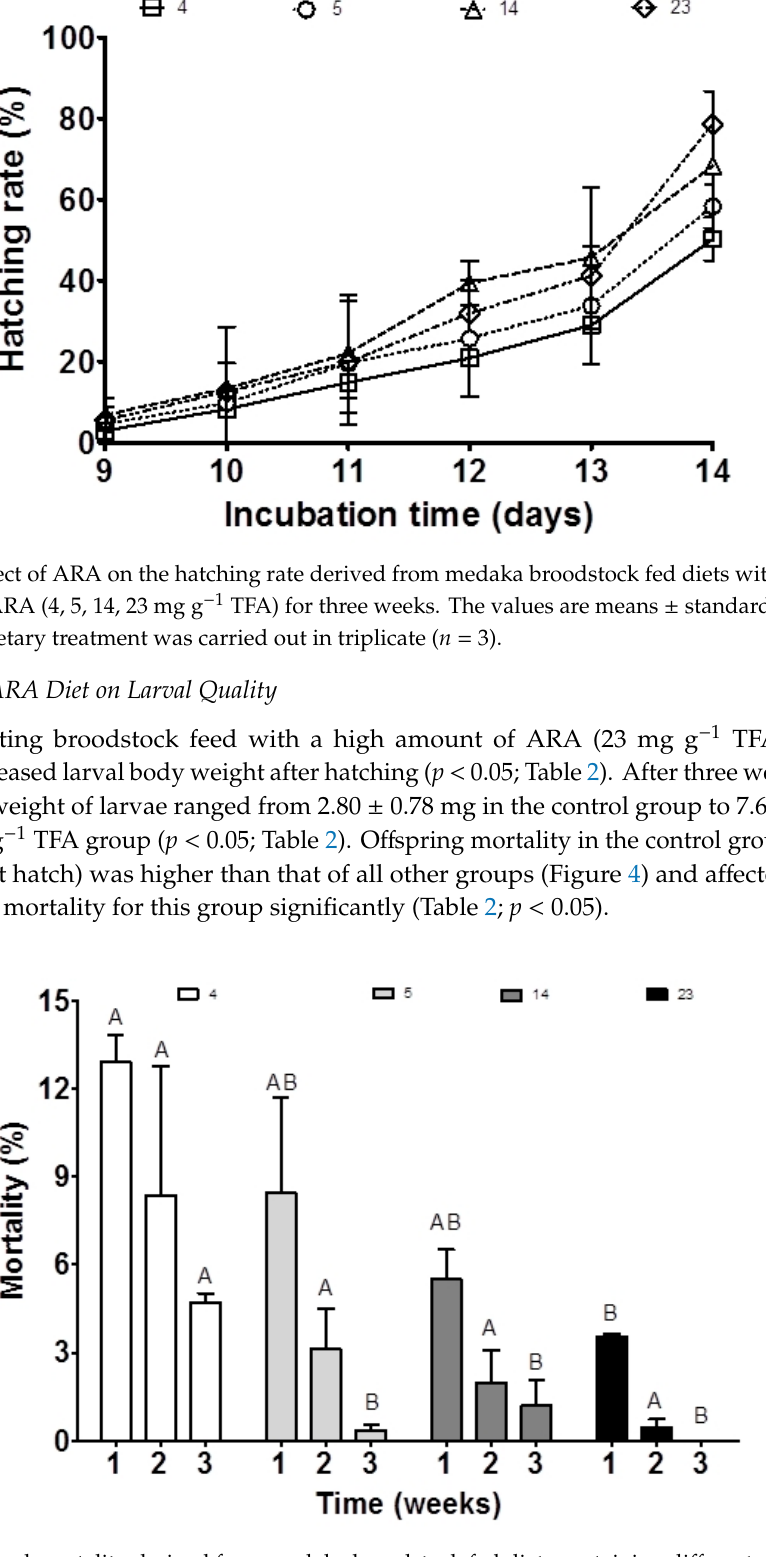
( p < 0.05) between groups in the given week of